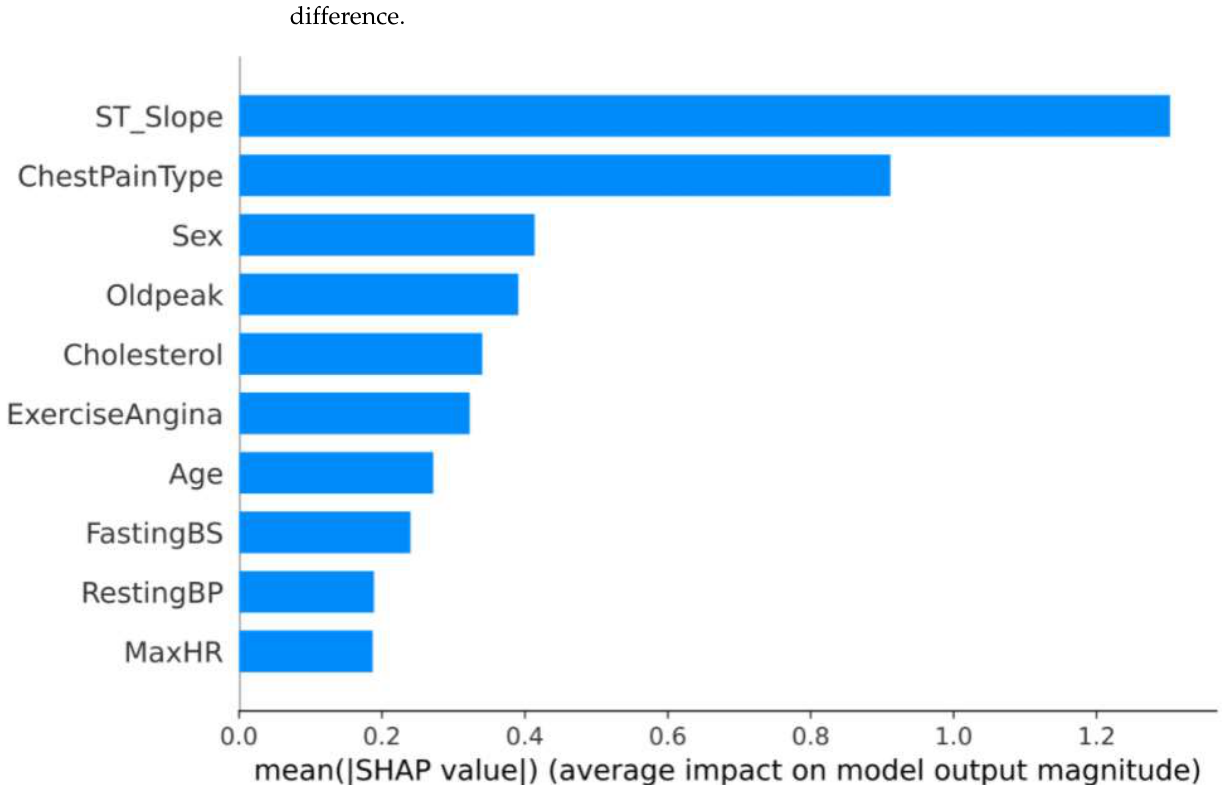
Figure 3. Global feature contributions.